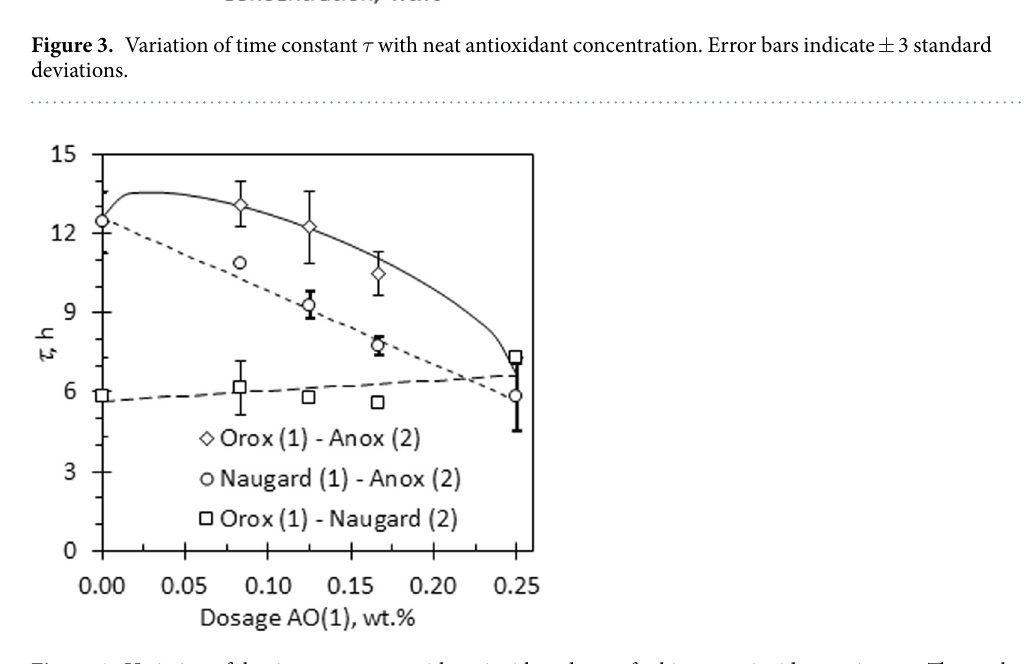
Figure 4. Variation of the time constant τ with antioxidant dosage for binary antioxidants mixtures. The total dose of antioxidant dose was held constant at 0.25 wt.%. Dosage reported in the graph is for the first antioxidant in the binary